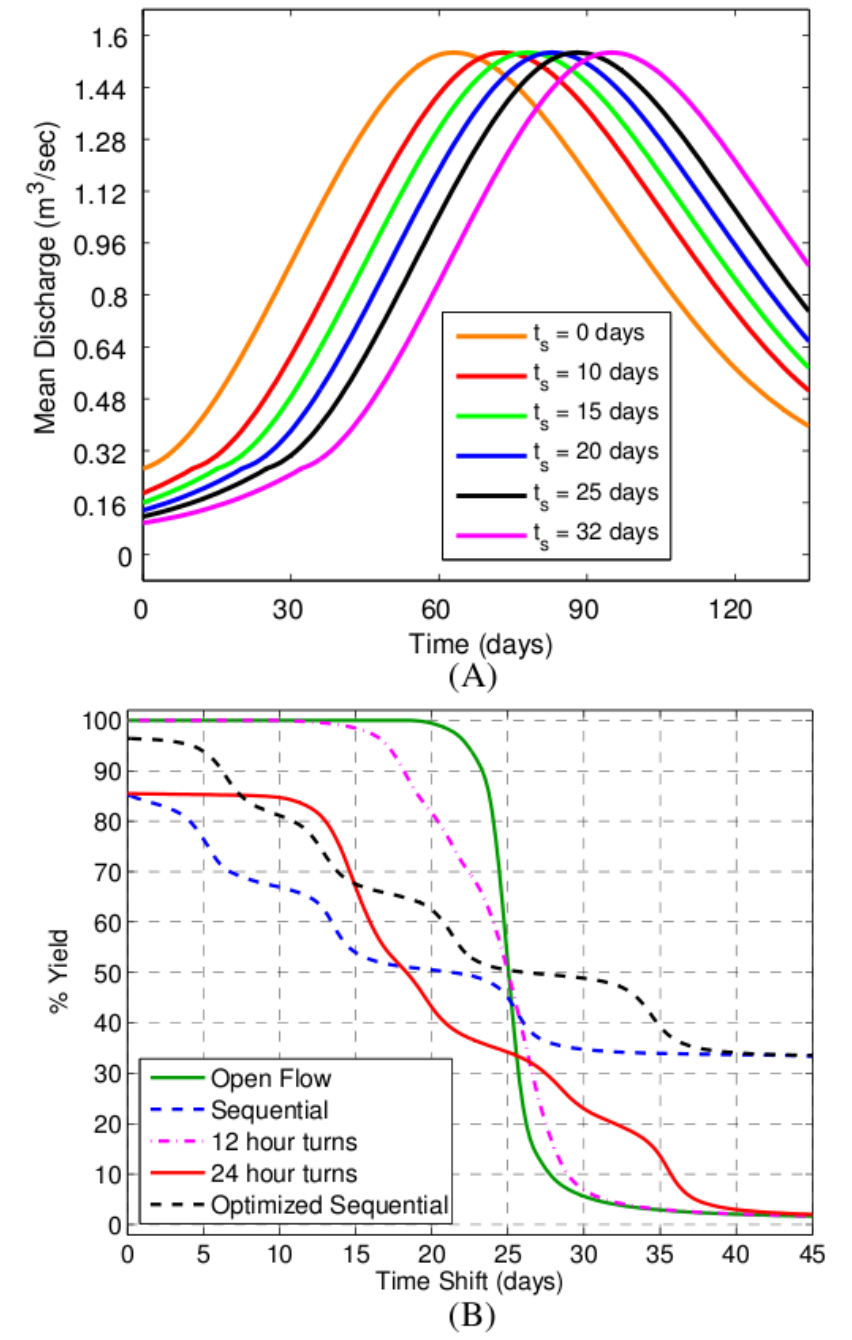
Fig. 9 . (A): Time-shifted mean river discharge scenarios. (B): Yields for different water distribution policies as a function of time shift in river